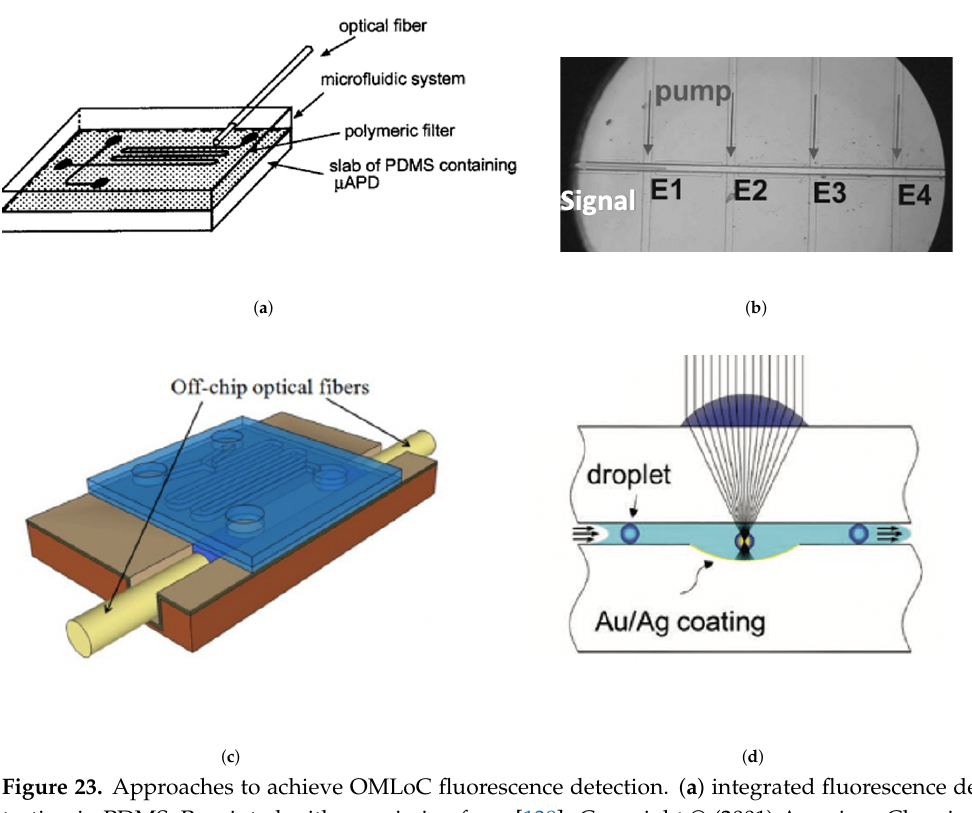
Figure 23. Approaches to achieve OMLoC fluorescence detection. ( a ) integrated fluorescence de- tection in PDMS. Reprinted with permission from [138]. Copyright © (2001) American Chemical Society. ( b ) Hollow and solid ARROW waveguides. Reprinted with permission from [139] © (2006) The Optical Society. ( c ) PDMS and ARROW integration. Reprinted with permission from [9] © (2014) The Optical Society. ( d ) Integrated co-axial mirror and lens system within a PDMS device. Reprinted from [140], copyright © (2020) John Wiley and